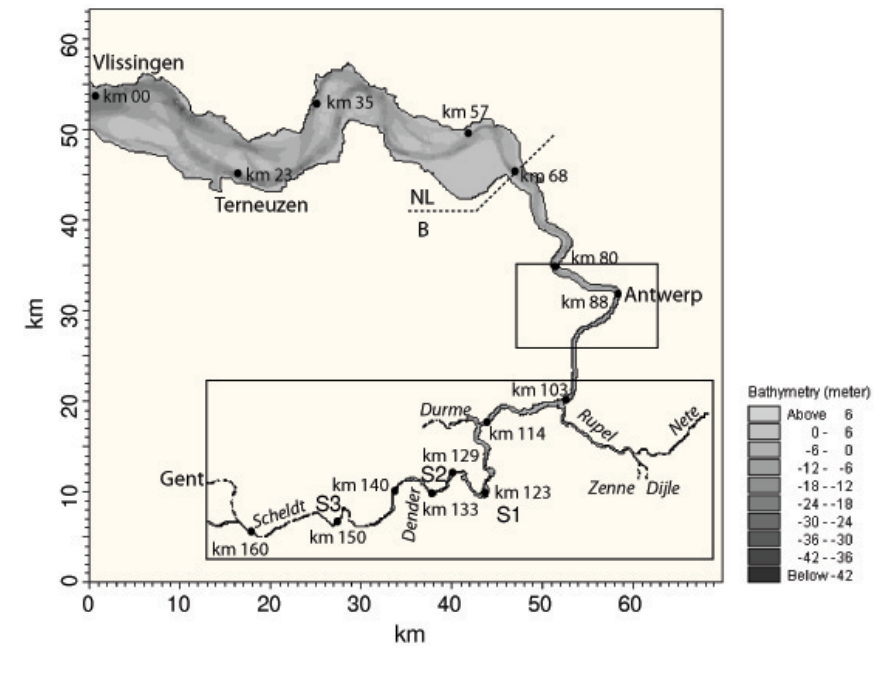
Fig. 1. Map of the Scheldt